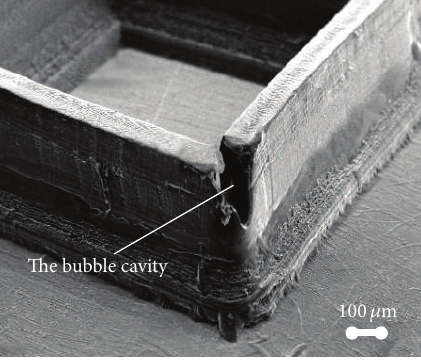
Figure 15: The SEM picture of a bubble